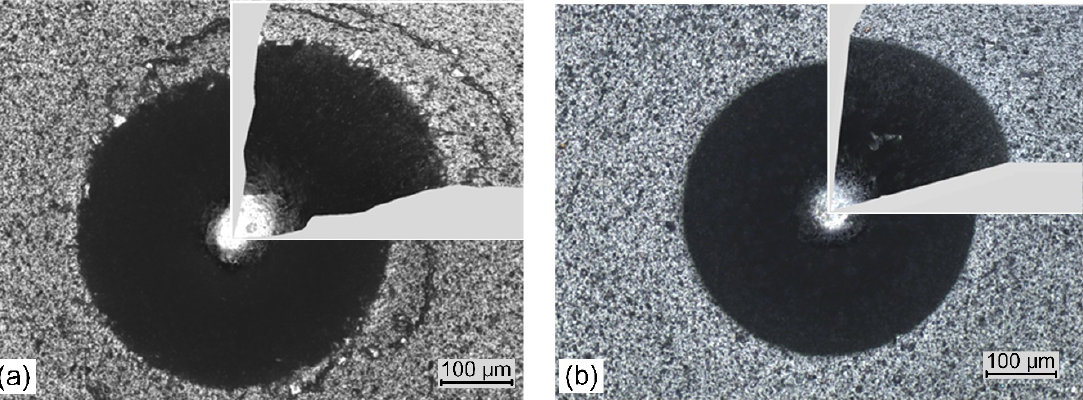
Figure 10. Daimler-Benz adhesion test results, SEM images of Rockwell indents for coatings formed at: ( a ) p N2 = 0.8 Pa and ( b ) p N2 = 5 Pa.